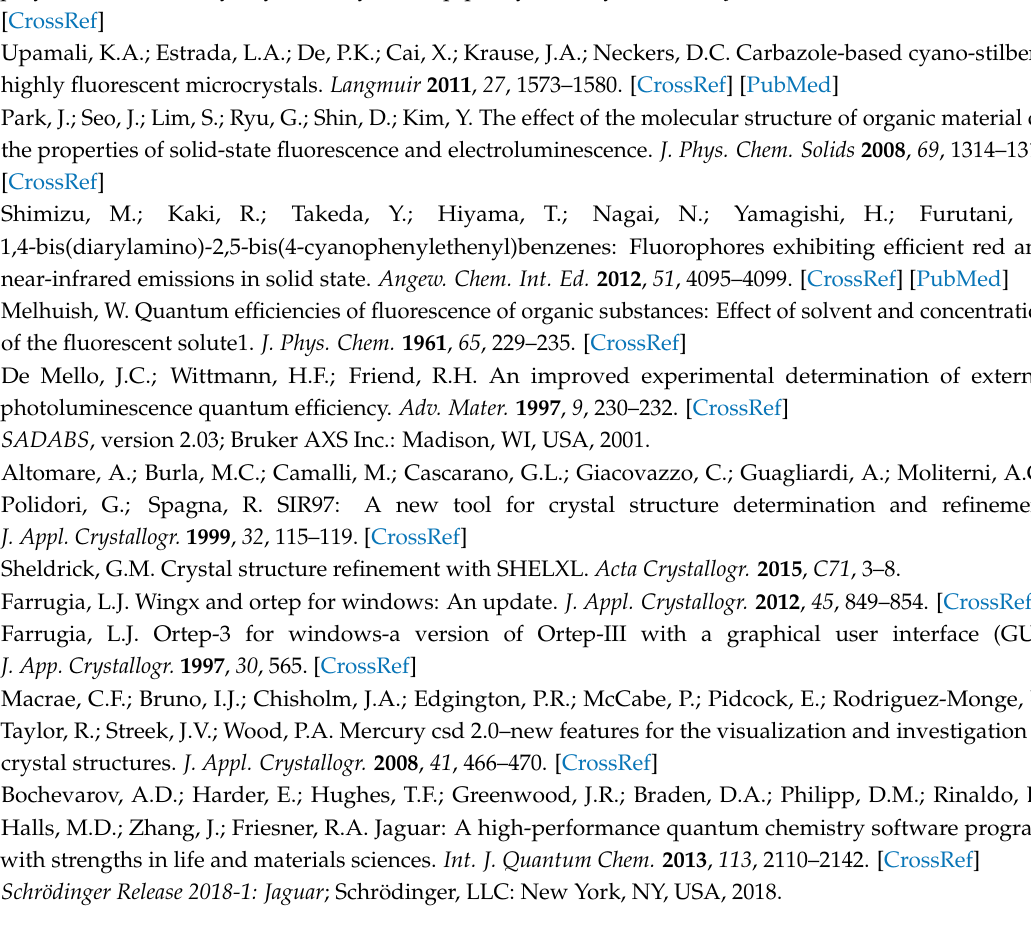
Sample Availability: Samples of the compounds CN-PV-NH 2 , CN-PV-NHMe and CN-PPV are available from the